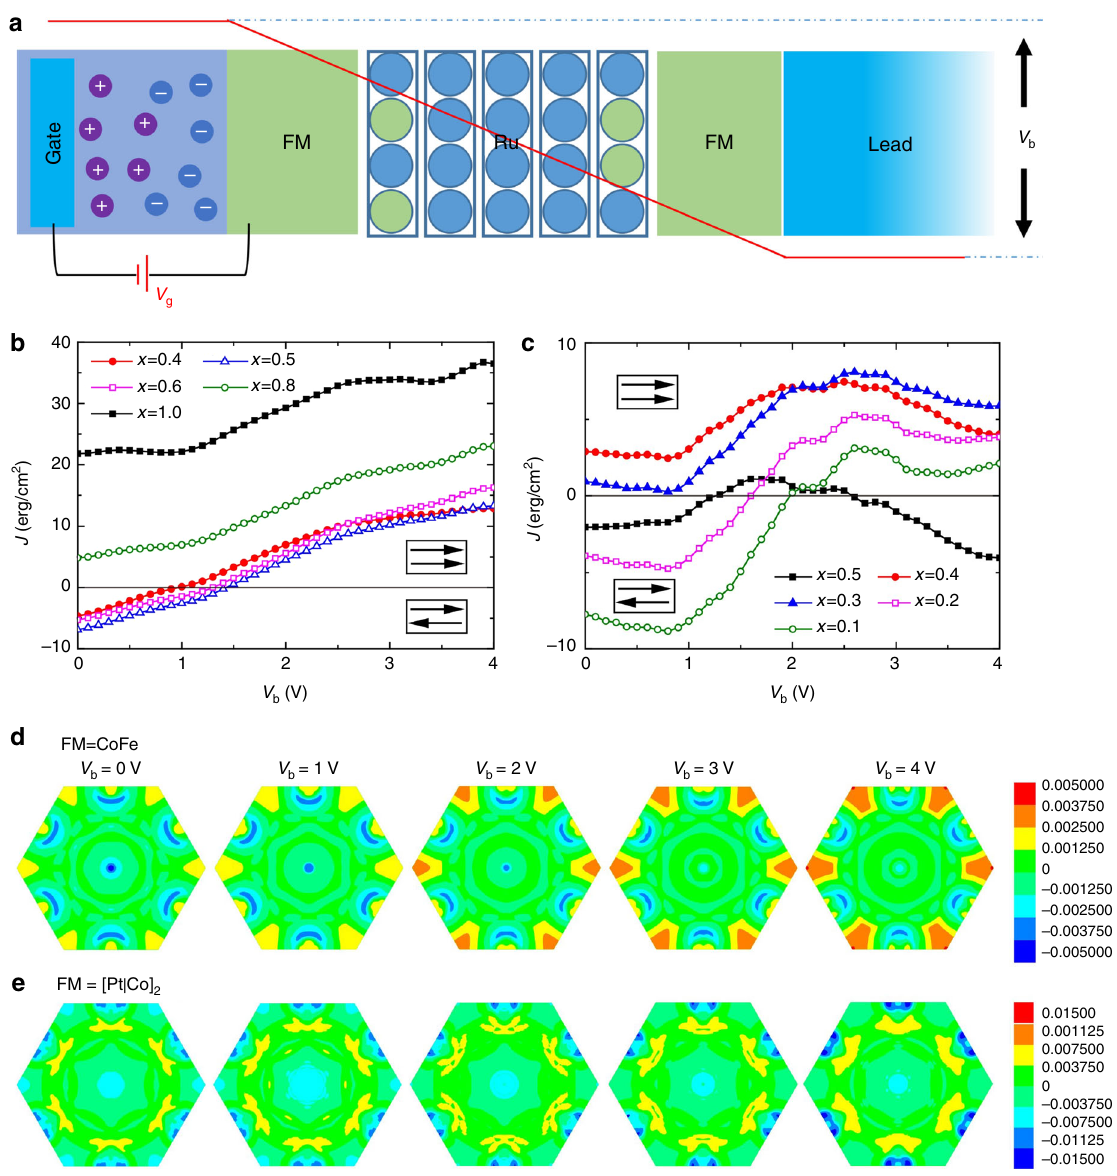
Fig. 6 Interlayer exchange coupling (IEC) simulation for Lead/FM/Ru/FM/Lead structure. a Schematic of the simulation model, here we chose Cu as a common lead and FM represents CoFe alloy or Pt|Co multilayers. Basically, the Ru on both left and right interfaces can be permeated by FM atoms as interface disordering. Under an applied V g , the chemical potential (Fermi energy) of the contacted FM layer was shifted up, which generated an equivalent voltage on the spin valve as V b (cid:3) V g . The red line stand for the arti fi cial potential drop with V b . b , c represent the IEC of FM = CoFe (1.5 nm) with 5 atomic layer of Ru (~1.1 nm) inside and FM = [Pt(0.88 nm)|Co(0.70nm)] 2 with 4 atomic layer of Ru (~0.88 nm) inside, respectively. We calculated the IEC as a function of V b and interface disorder concentrations x , which means that the interface is structured as Ru x (CoFe) 1- x or Ru x Co 1- x for different cases. d , e stand for the dimensionless k || -resolved IEC for FM = CoFe and FM = [Pt|Co] 2 multilayer, respectively. Here we chose fi ve V b points from b ( x = 0.5) and c ( x = 0.1) under various gating